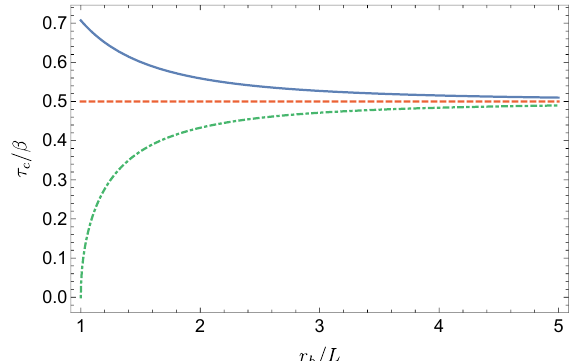
Figure 3 . Critical time t c as a function of the horizon radius for d = 4 for the various horizon geometries, i.e.,spherical k = 1 (blue), planar k = 0 (dashed-red) and large hyperbolic k = (cid:0) 1 (dot-dashed green). Note that we only consider r h > L .